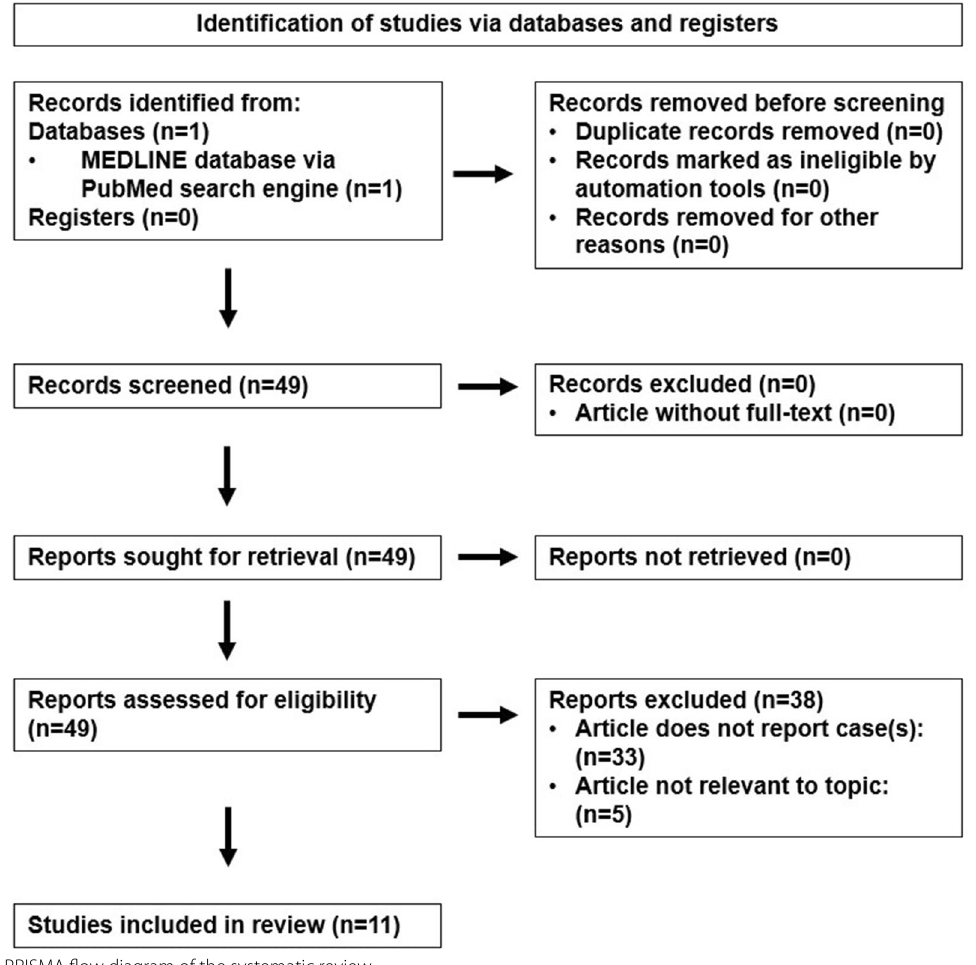
Fig. 1 2020 PRISMA flow diagram of the systematic